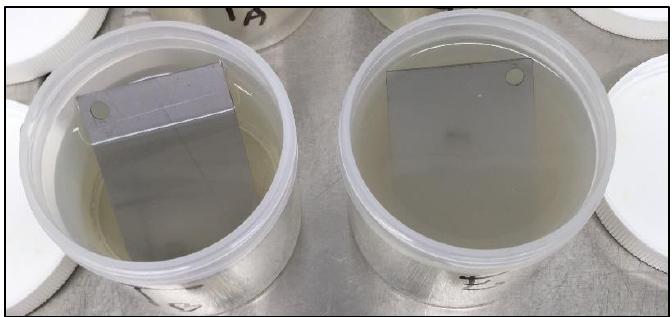
Figure 8. Overview of jars after 14 h of exposure to 14.1. On the left is one of the triplicate jars containing viruses. On the right is one of the triplicate controls without treatment applied. The turbidity of each one was compared by the optical density measurement of the surrounding mineral minimum medium (OD 600 nm ). Values were negative in the case of treated jars and between 0.2 and 0.4 for controls. Note that the e ff ect of phages on the surrounding mineral minimum medium was only measured in the case of 14.1.